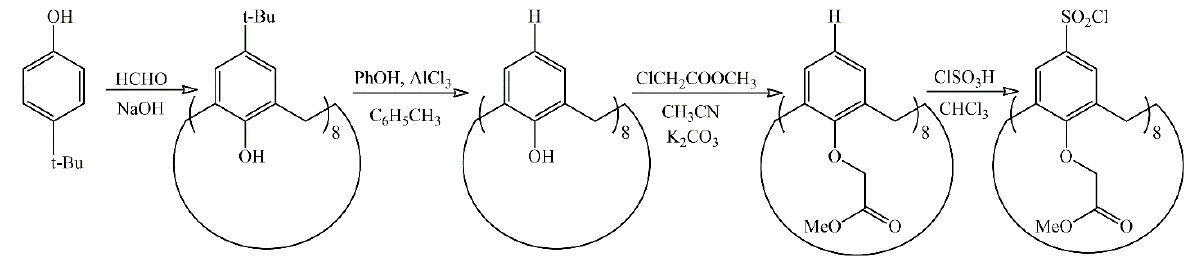
Figure 3. Synthesis of the octafunctional macrocyclic initiator.